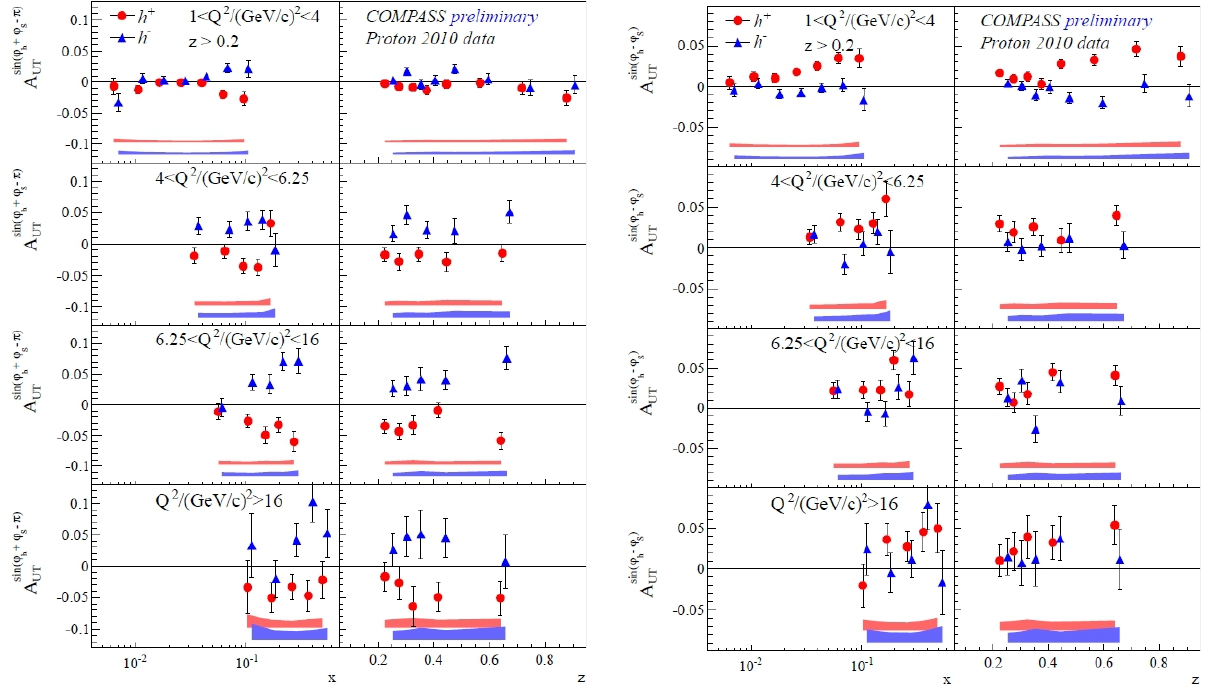
Figure 11. Collins (left) and Sivers (right) asymmetries for 4 Q 2 bins as a function of x and z .